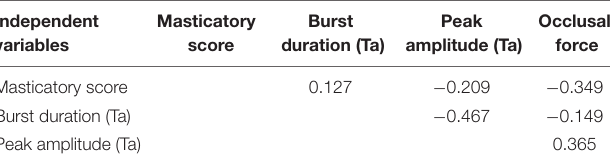
TABLE 5 | Bivariate Pearson’s correlation coefficients between independent variables of masticatory score, burst duration [anterior temporal (Ta)], peak amplitude (Ta), and occlusal force in the regression